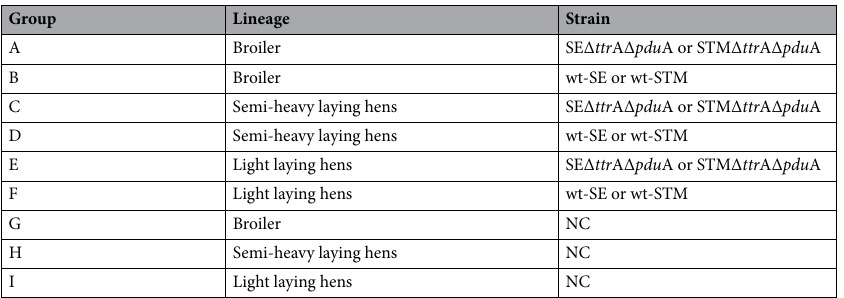
Table 7. Established groups according to the different lineages and strains. SE∆ ttr A∆ pdu A, Salmonella Enteritidis ∆ ttr A∆ pdu A; STM∆ ttr A∆ pdu A, Salmonella Typhimurium ∆ ttr A∆ pdu A; wt-SE, Salmonella Enteritidis wild-type; wt-STM, Salmonella Typhimurium wild-type; NC, negative